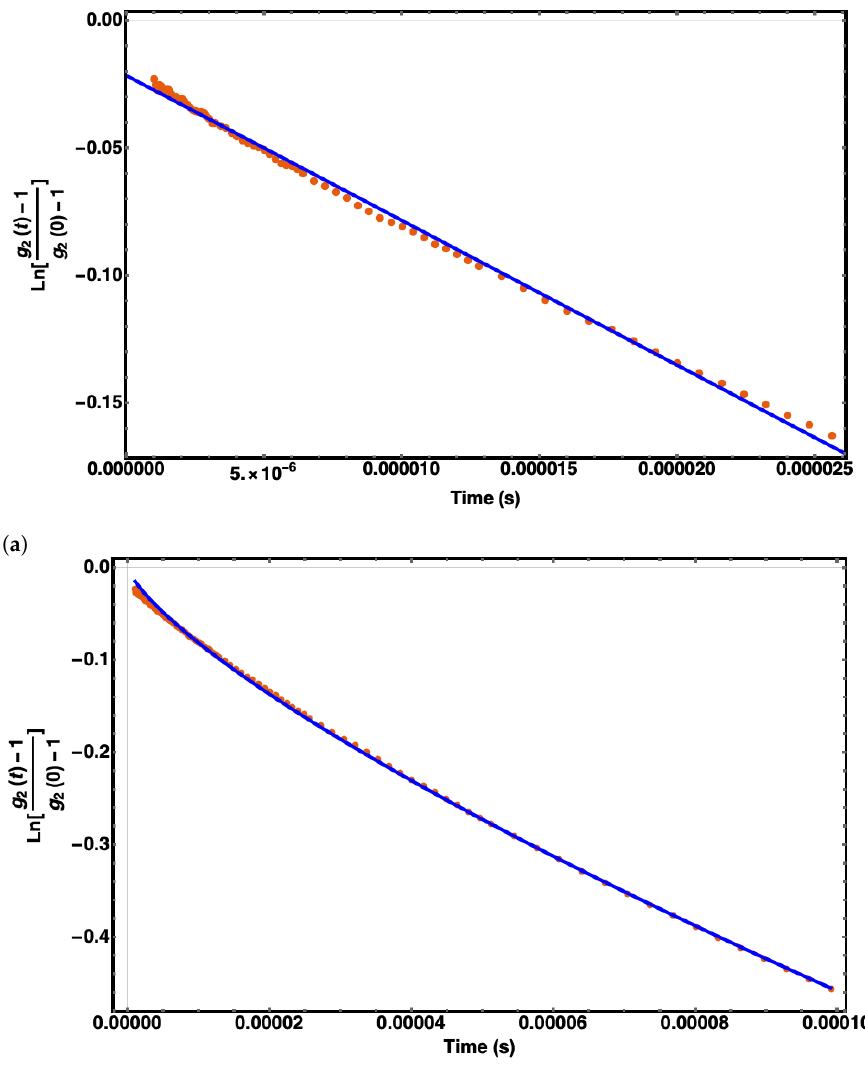
Figure 6. Illustrative examples of the fitting approach to obtain the filament’s hydrodynamic di- ameter and persistent length. ( a ) The initial decay rate ( γ 0 ) was extracted using Equation (21) and a linear fitting curve in the time window [ 10 − 6 s, 2.5 × 10 − 5 s ] . This value is used to obtain the hydrodynamic diameter. ( b ) The persistence length ( L p ) was extracted using the result for the hydro- dynamic diameter obtained in ( a ), Equation (22) and a non-linear fitting curve in the time interval [ 10 − 6 s, 10 − 4 s ]